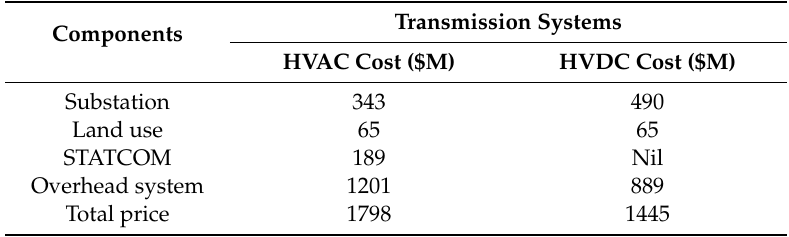
Table 3. HVAC and HVDC systems investment cost comparison